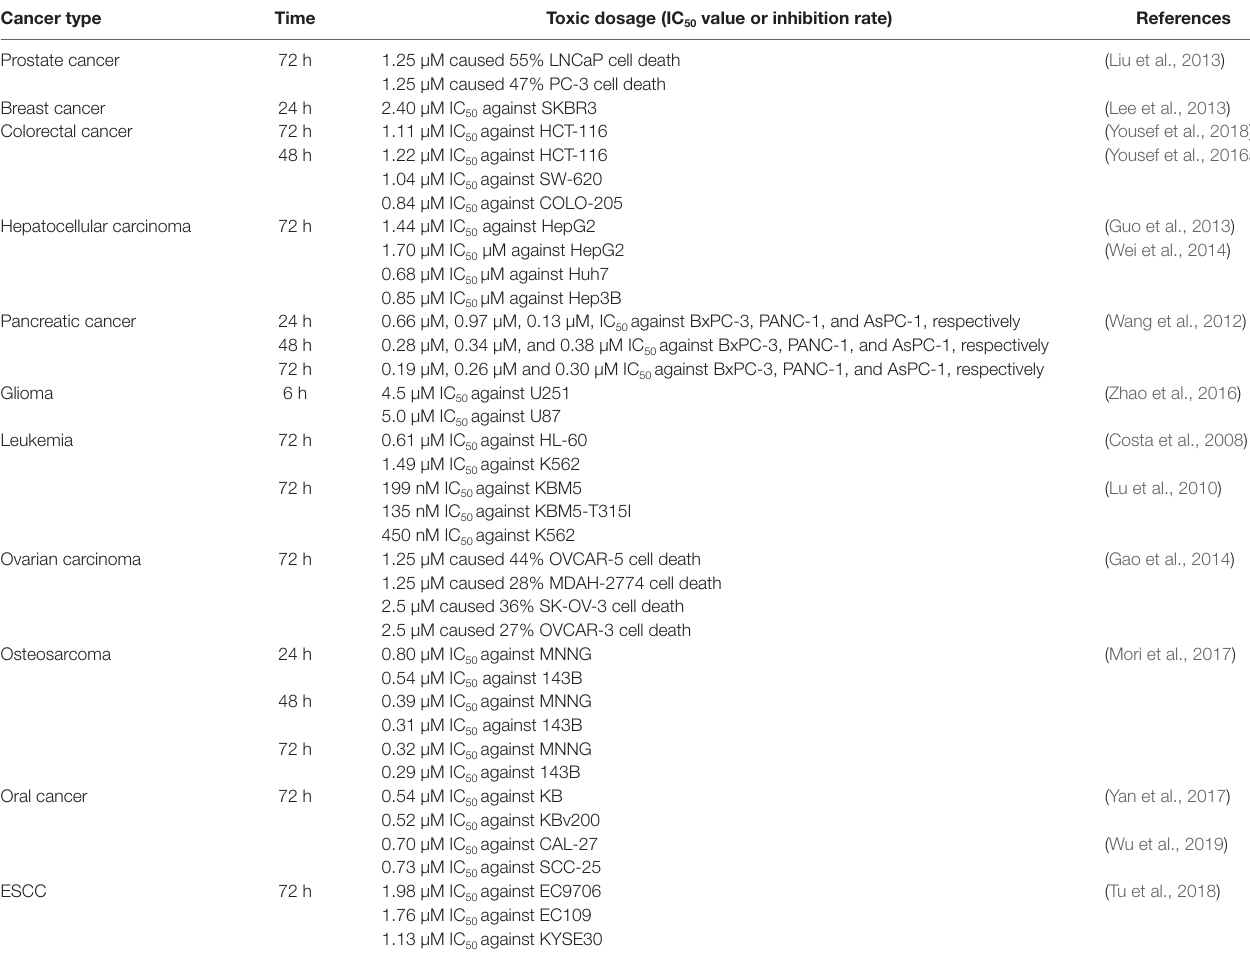
TABLE 1 | The cytotoxicity dosage of pristimerin in different cancer cell lines. Cancer